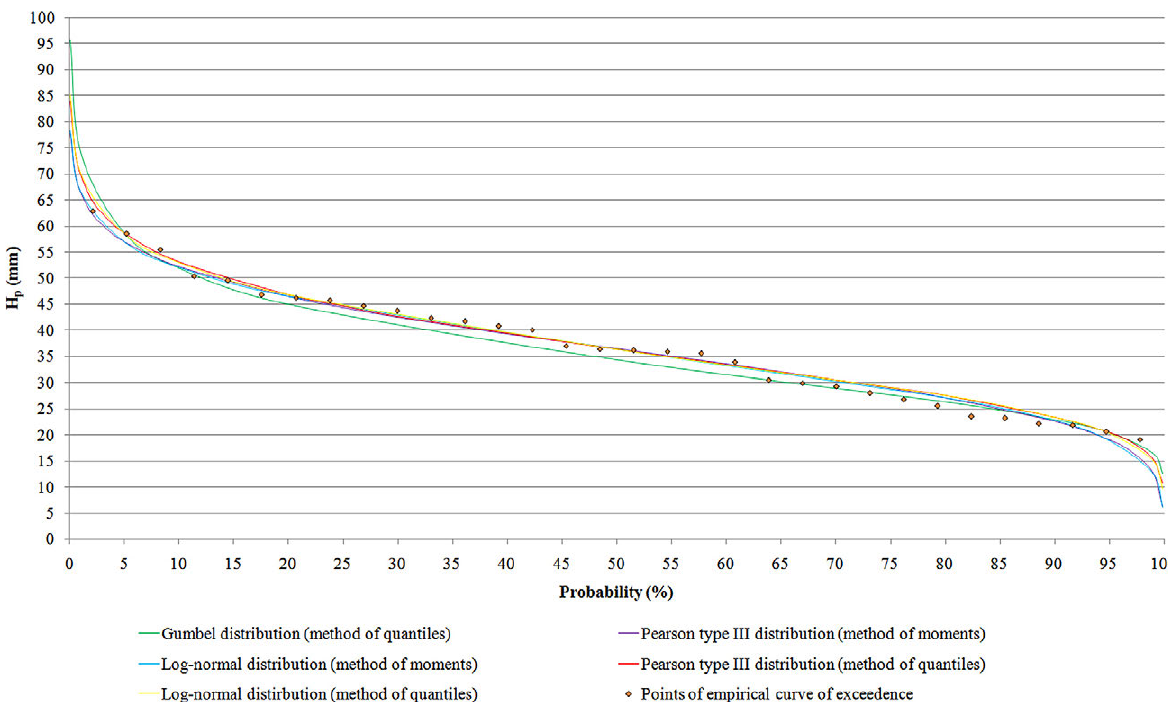
Fig. 5. Comparison of empirical and theoretical curves of exceedence in the klátova Nová Ves rain gauge